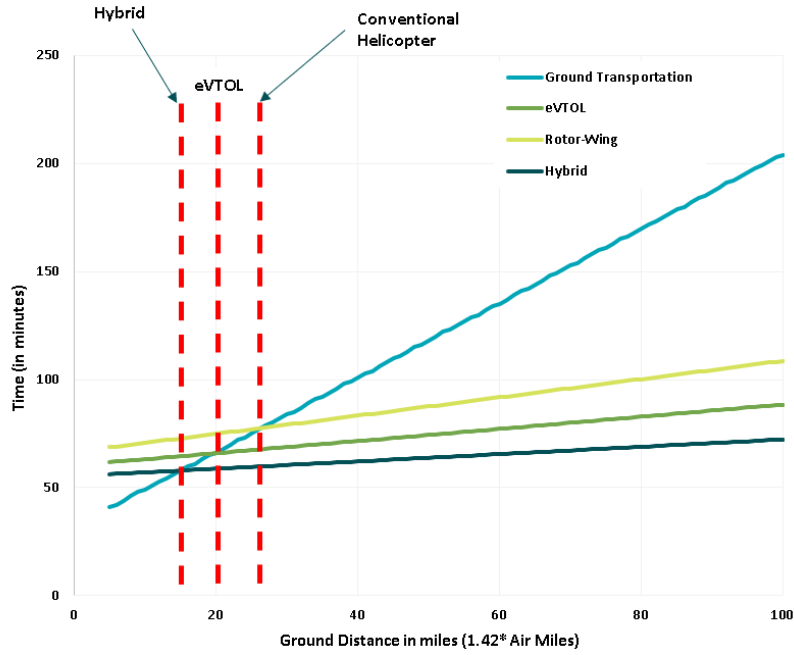
Figure 4. Transportation times as a function of distance for different types of ambulances.